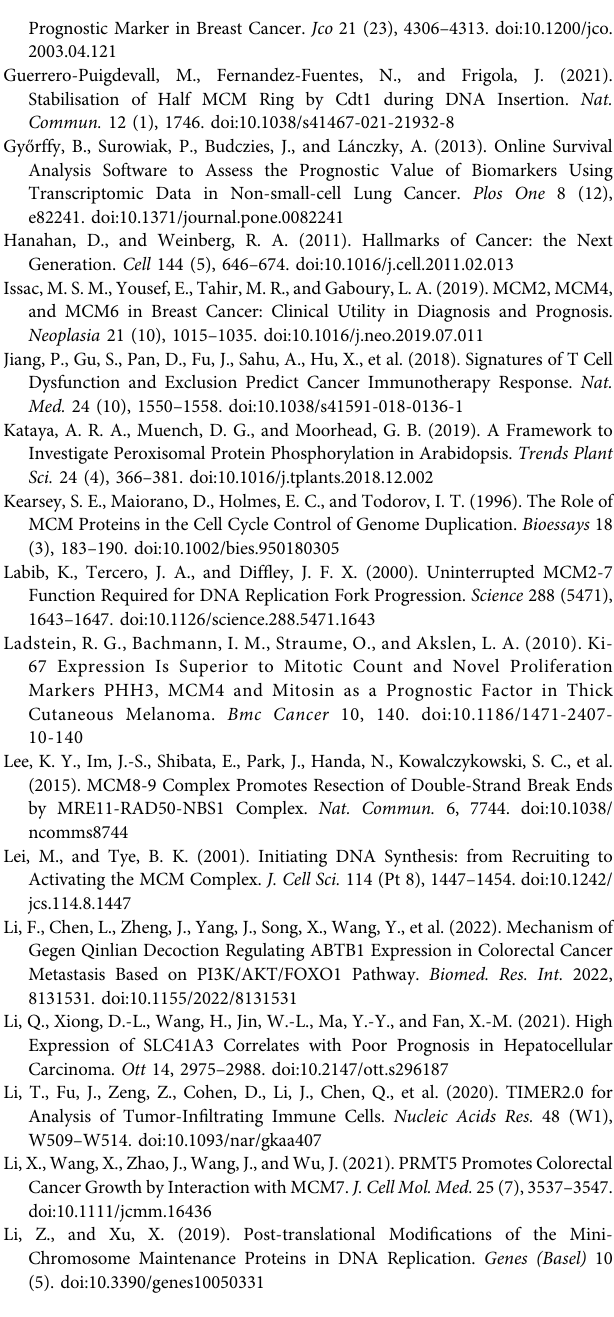
Supplementary Figure S1 | The somatic mutations of MCM2 in various cancers. Pie chart showing the percentage of different MCM2mutations in the breast, cervix, kidney, liver, lung, prostate, skin, stomach, and thyroid according to the COSMIC